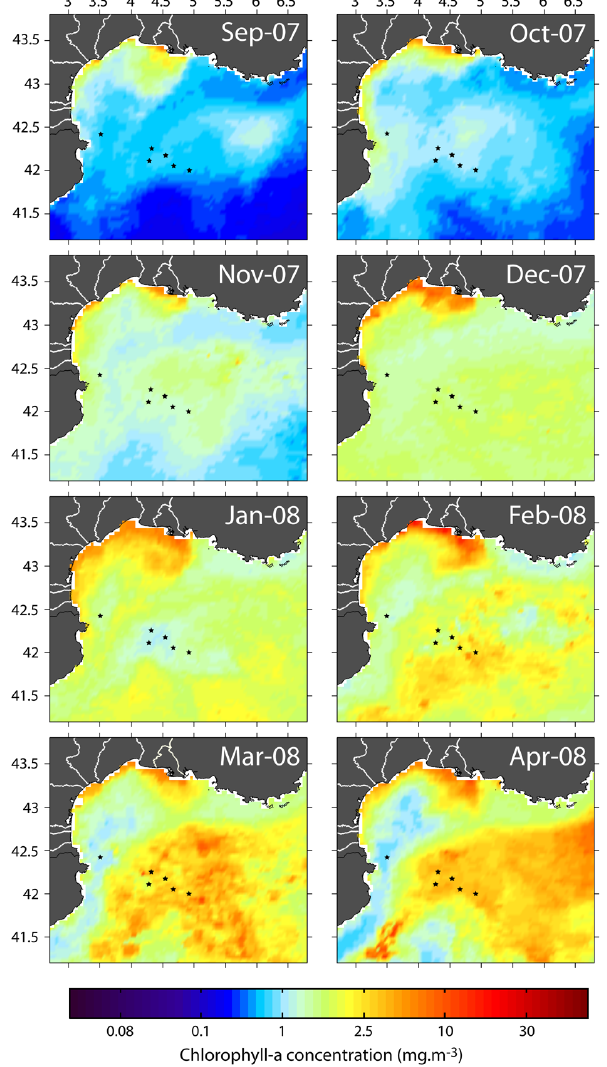
Fig. 2. Monthly averaged MODIS-Aqua 4km surface chl a images from September 2007 to April 2008. Black stars indicated the lo- cation of the mooring sites. Satellite data were downloaded from NASA’s Giovanni portal